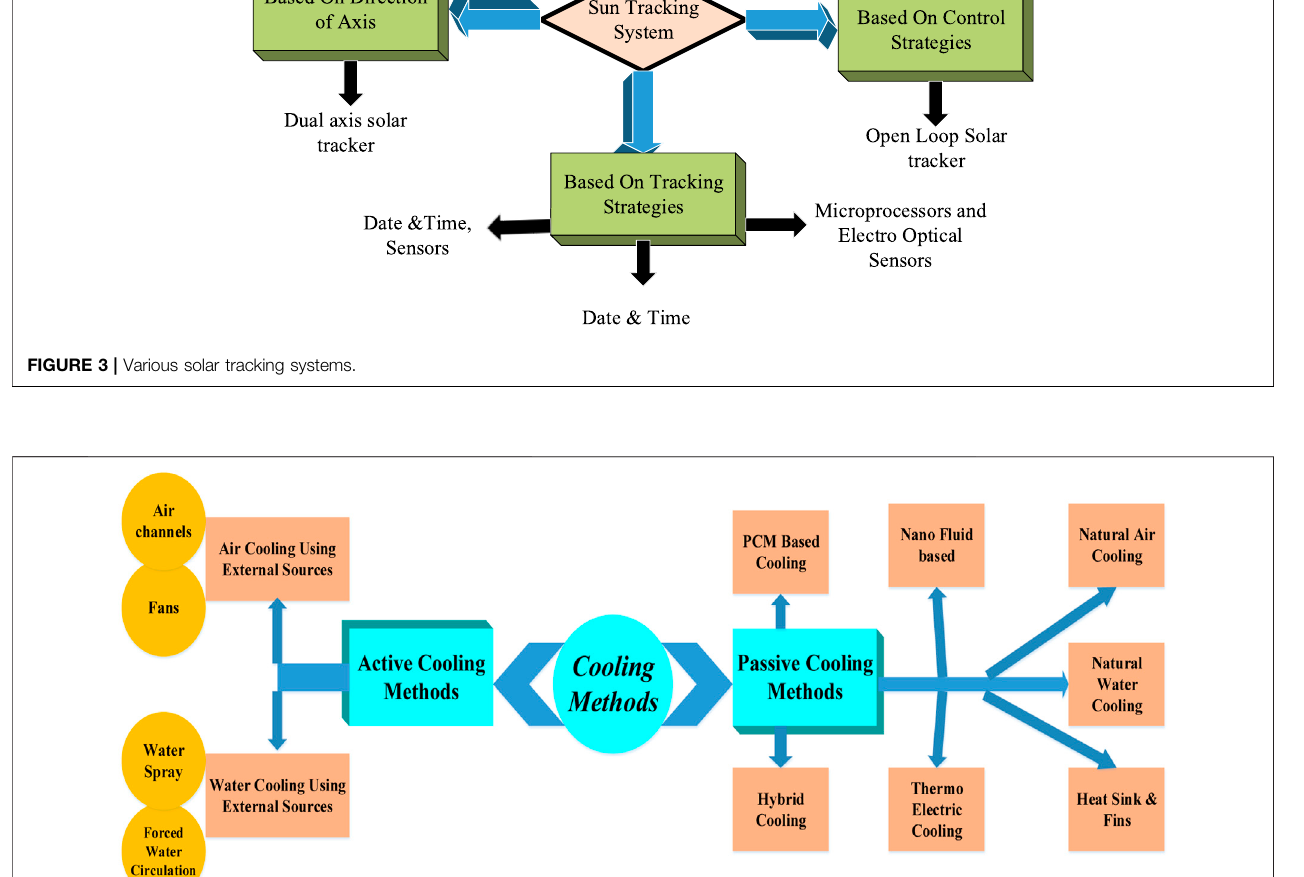
FIGURE 4 | Various cooling methods used in PV panels to enhance ef fi ciency.